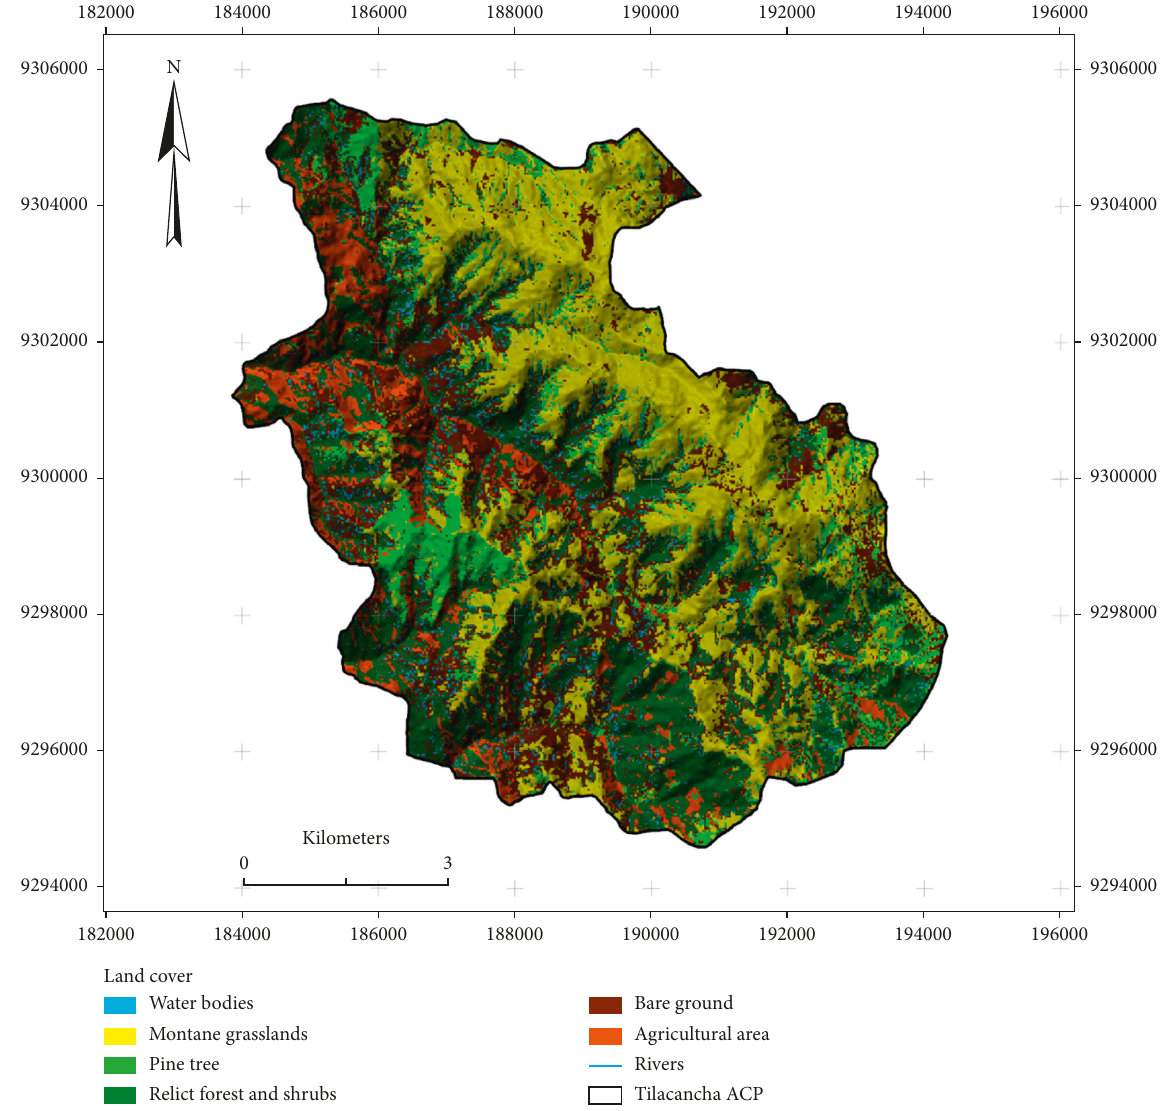
Figure 4: Resulting maps to determine the K factor: (a) soil texture and (b) organic matter in the Tilacancha